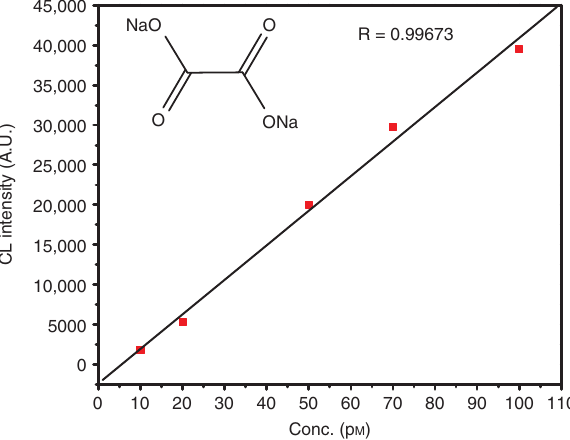
Figure 8: (A) The individual CL signal vs. time using different amounts of TiO NPs (mg) using oxalate as an analyte at a flow rate of 200 ml/h.